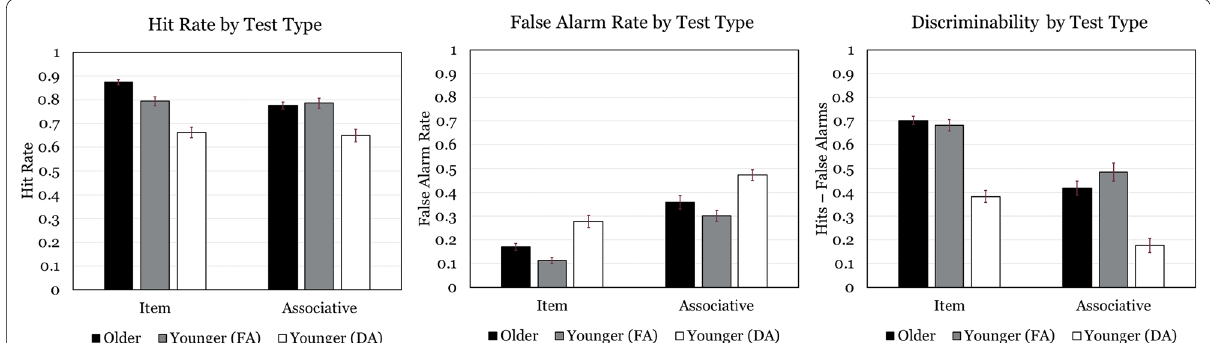
Fig. 2 Hit rate, false alarm rate, and average discriminability for each test type and age/attention group. Although planned analyses compared two age/attention groups at a time, all three groups are graphically presented together in these and remaining figures to avoid redundancy. FA Attention, DA Divided =